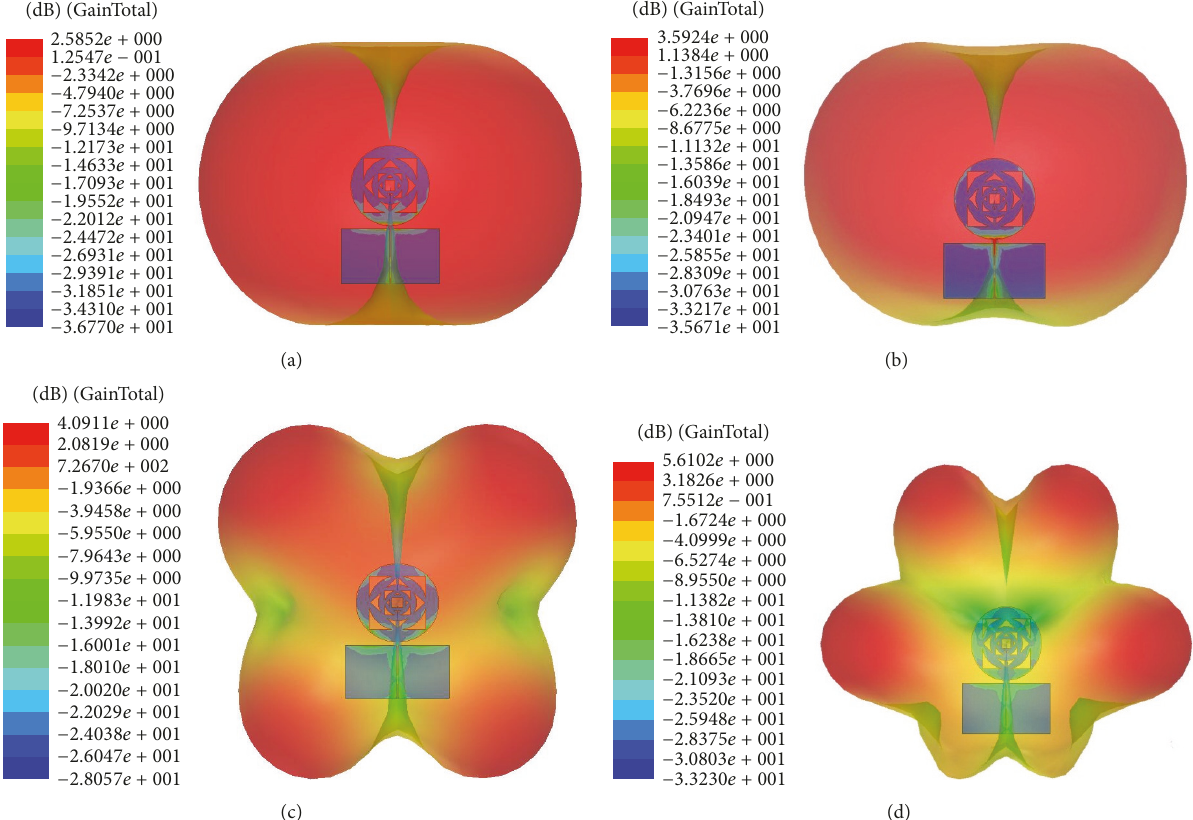
Figure 7: 3D radiation patterns at (a) 1.6GHz, (b) 2.6 GHz, (c) 3.7 GHz, and (d) 5.3 GHz.